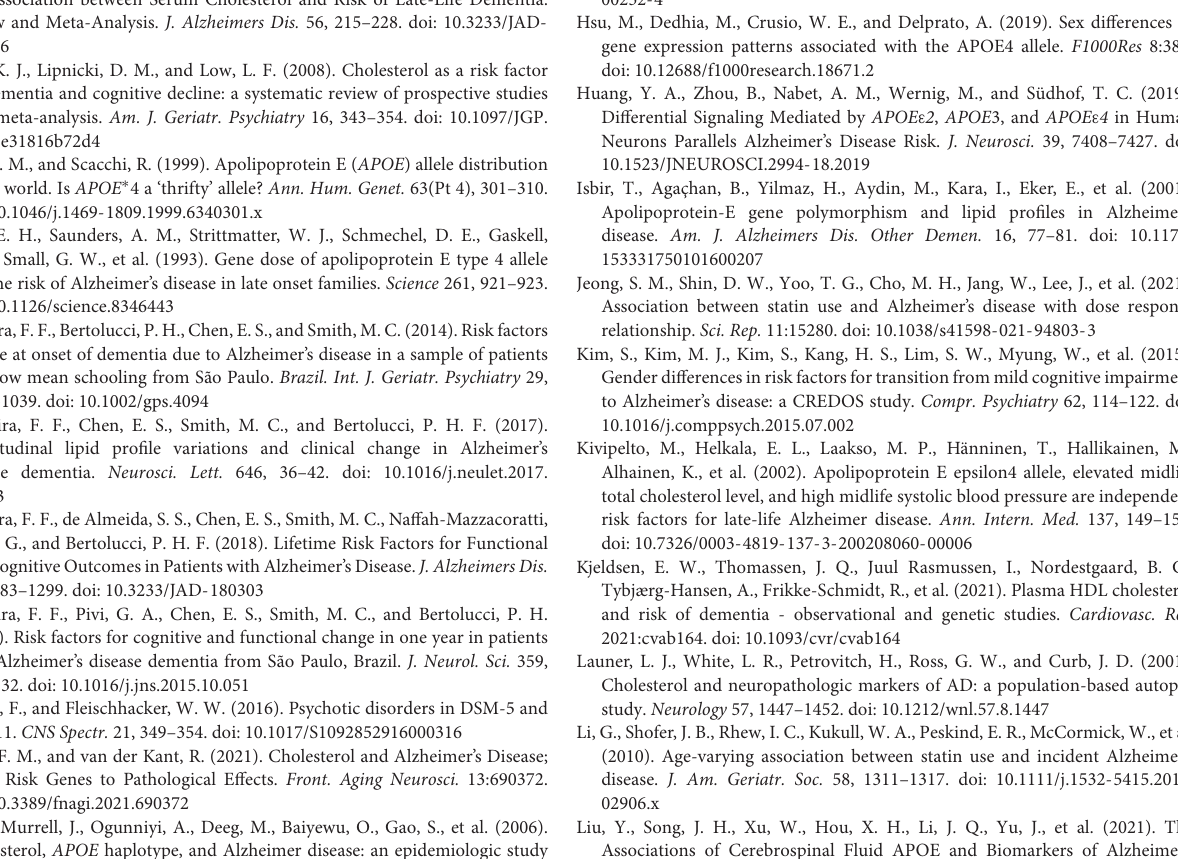
Supplementary Table 4 | Comparison of lipids between male and female (Adjusting for age and the stain use); Values are expressed as mean (standard